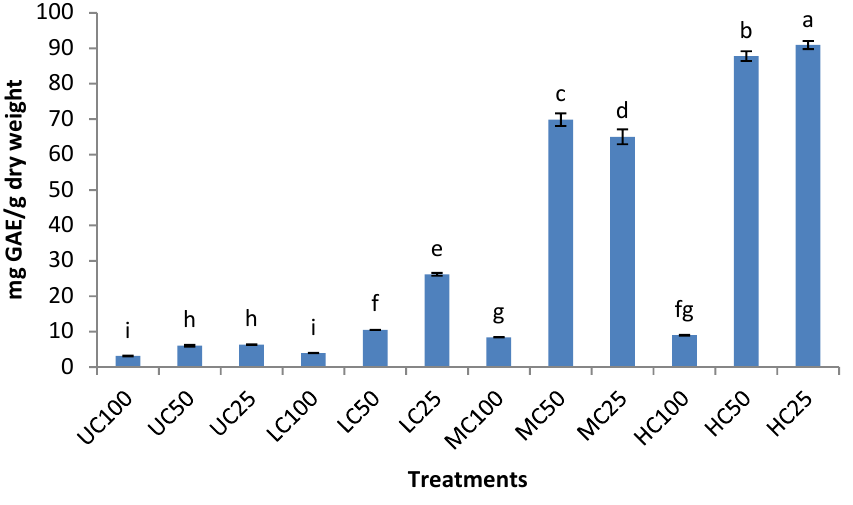
Figure 2. Total polyphenol content of air-fried eggplant. The treatment codes consisting of different letters and digits represent the uncooked (UC), high-cooked (HC), medium-cooked (MC), and low-cooked (LC) eggplant samples extracted with absolute ethanol (100), 50% ethanol (50), and 25% ethanol (25). The bars containing different letters are significantly different from each other ( p < 0.05). GAE: gallic acid equivalent.